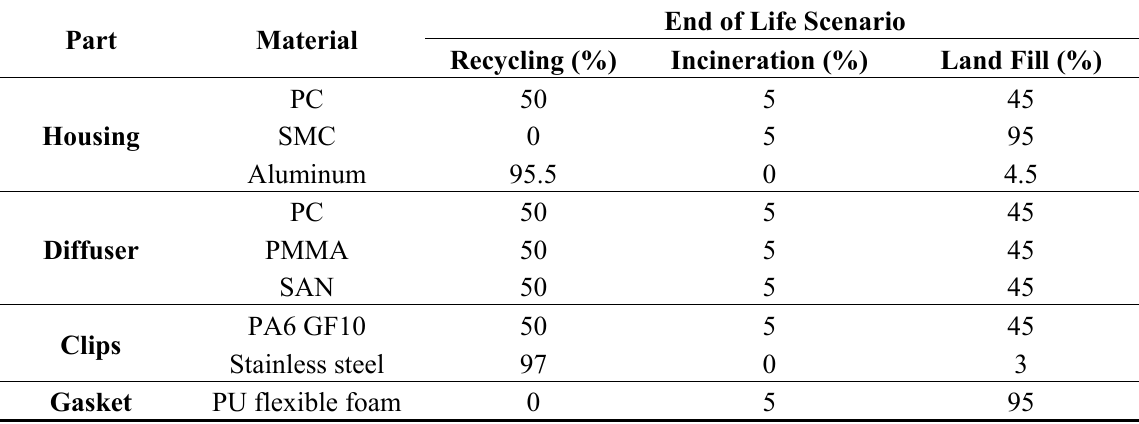
Table 6. End of life Scenario 2.